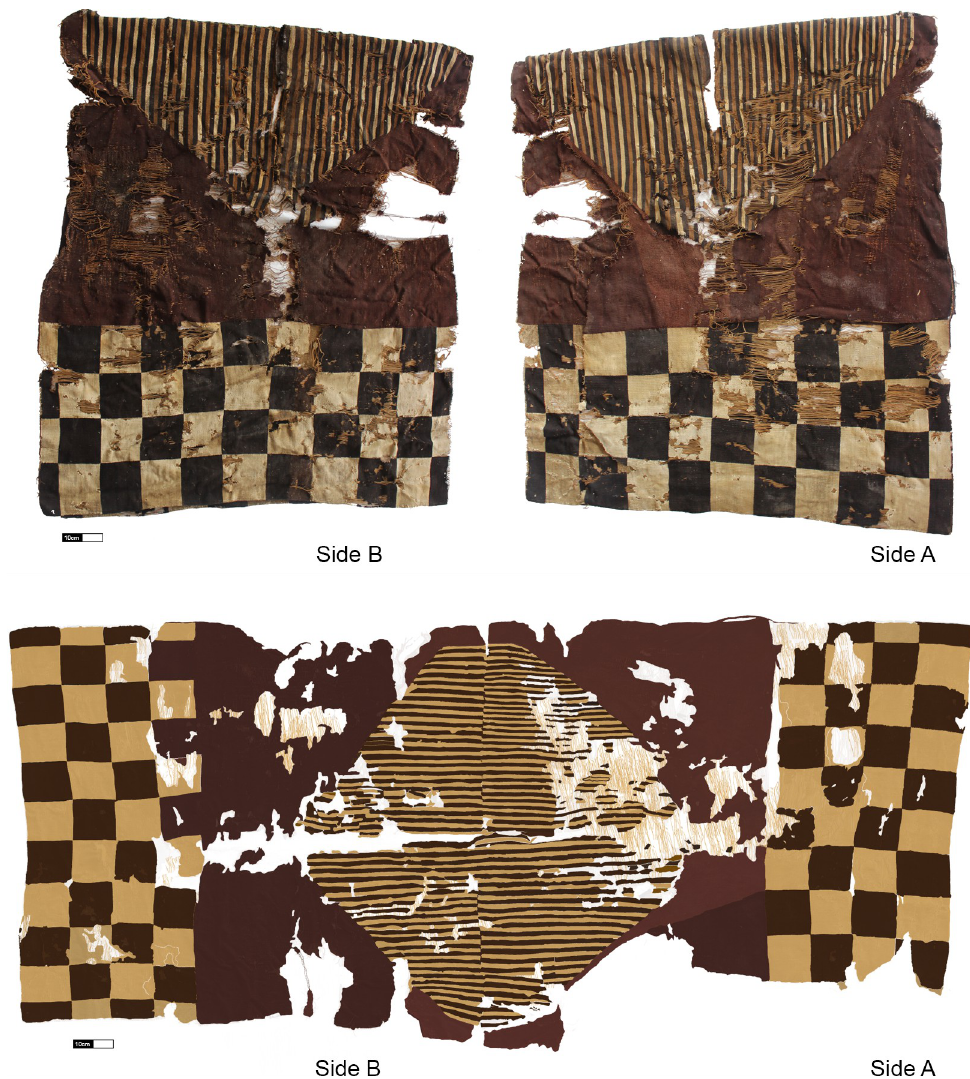
Fig 1. Unku found in Caleta Vitor Bay. Top: sides A and B from the wearer’s point of view (photographs by Paola Salgado); bottom: illustration of the tapestry tunic from the weaver’s position and viewpoint (illustration by Paola